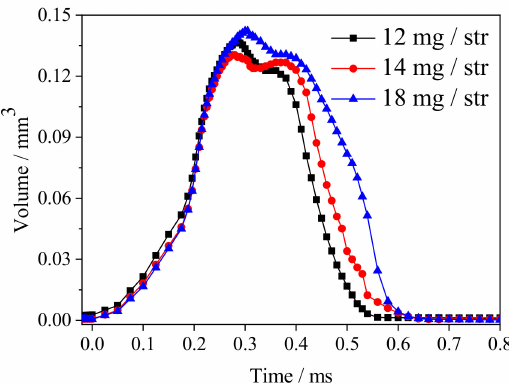
Figure 9. The change of total cavitation in the nozzle under different mass fluxes.